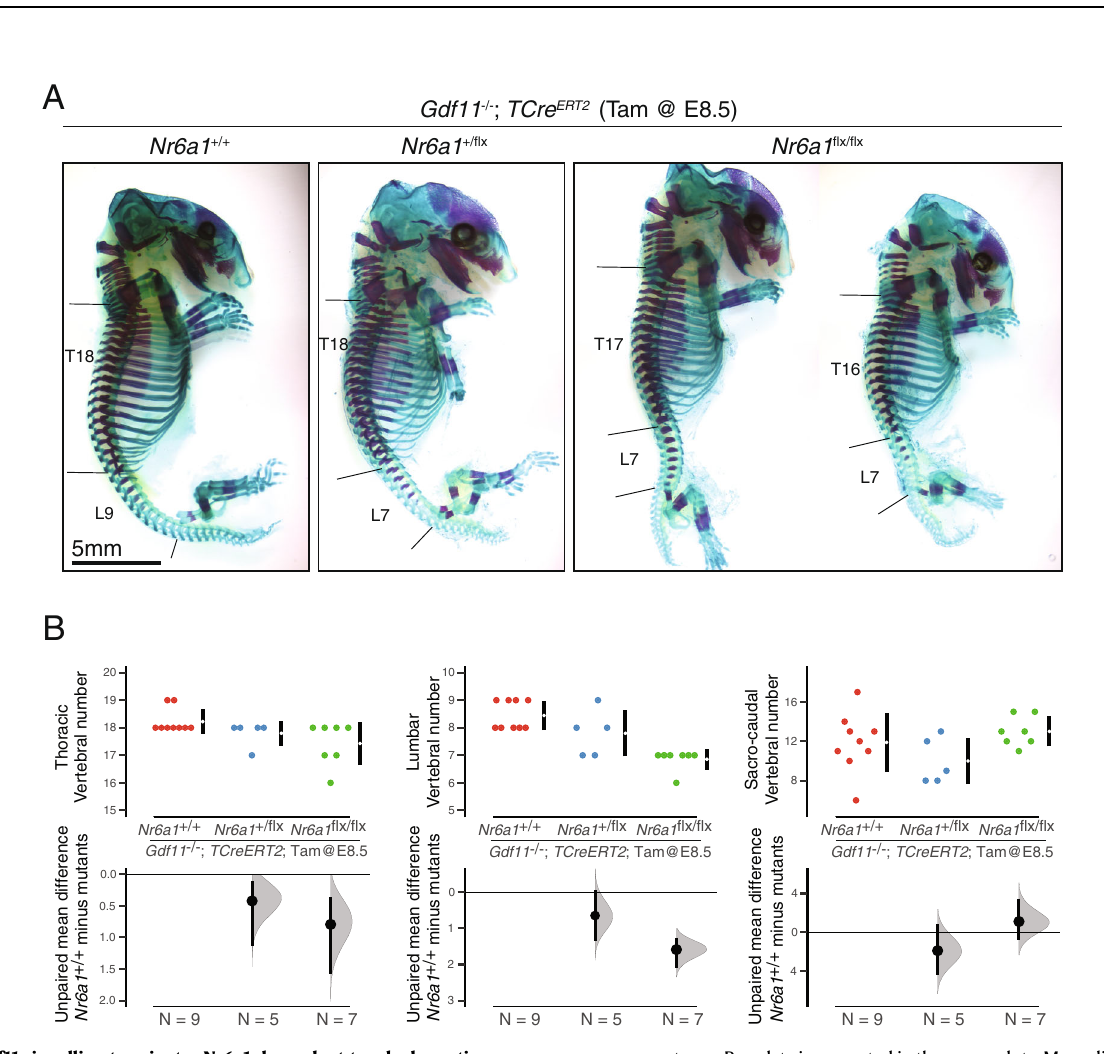
across genotypes. Rawdata is presented intheupper plots. Mean differences were calculatedrelativeto Gdf11 − / − ; Nr6a1 +/+ andpresentedinthelowerplotsasbootstrap sampling distributions. The mean difference for each genotype is depicted as a black dot and 95% con fi dence interval is indicated by the ends of the vertical error bar.